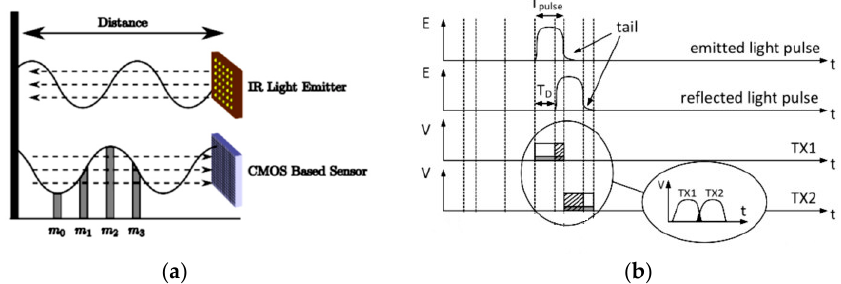
Figure 2. Principle of time of flight image collection: ( a ) distance measurement based on continuous-wave modulation; ( b ) distance measurement based on pulsed modulation.